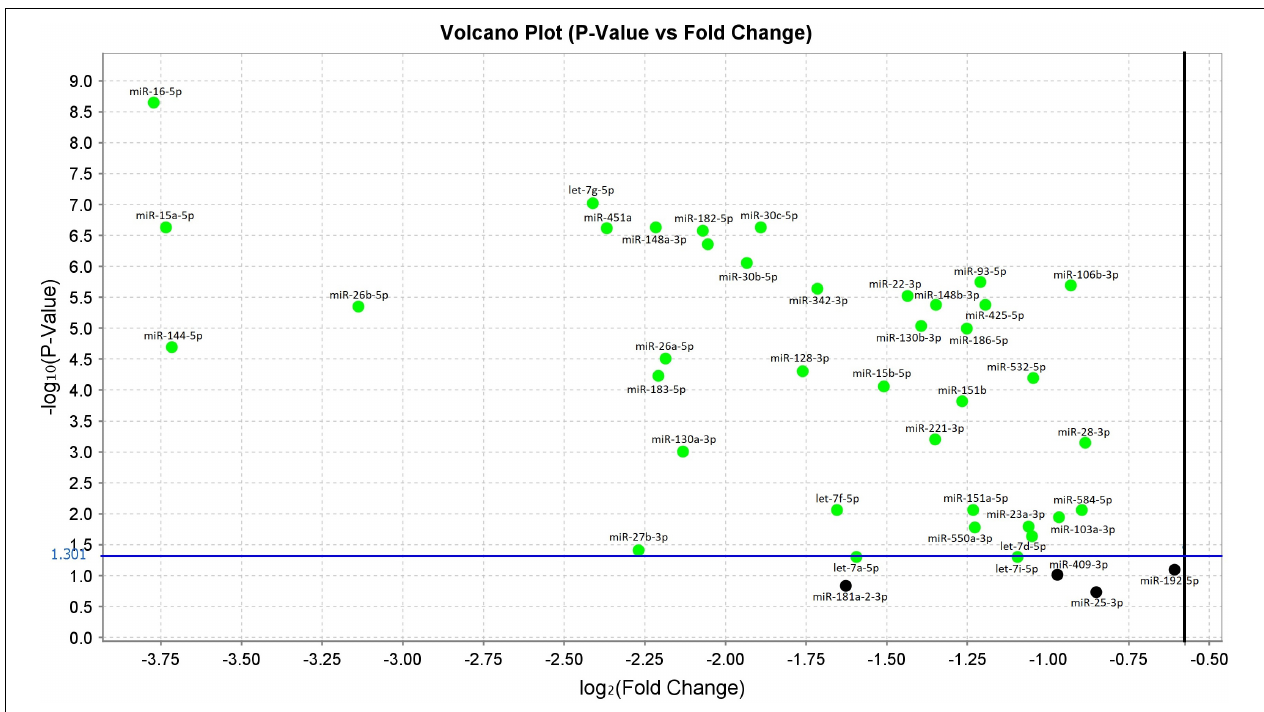
FIGURE 1 | Volcano plot of validated miRNAs. Green dots represent the 38 differentially expressed miRNAs obtained from the comparison between sALS and HC subjects by qRT-PCR ( p < 0.05). All black dots below the blue line did not discriminate sALS from HC. The Y-axis represents the log10 of the p -value and the X-axis represents log fold change of miRNA expression in the sALS versus